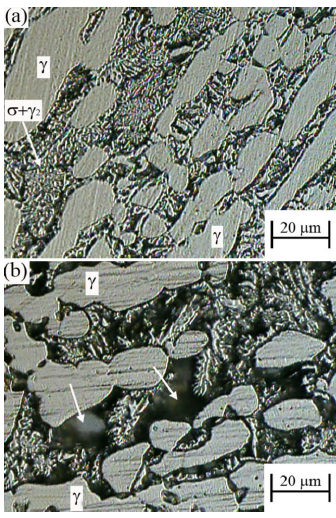
Figure 11. SD-B aged at 900 °C for 45 minutes, after DL-EPR test at room temperature.